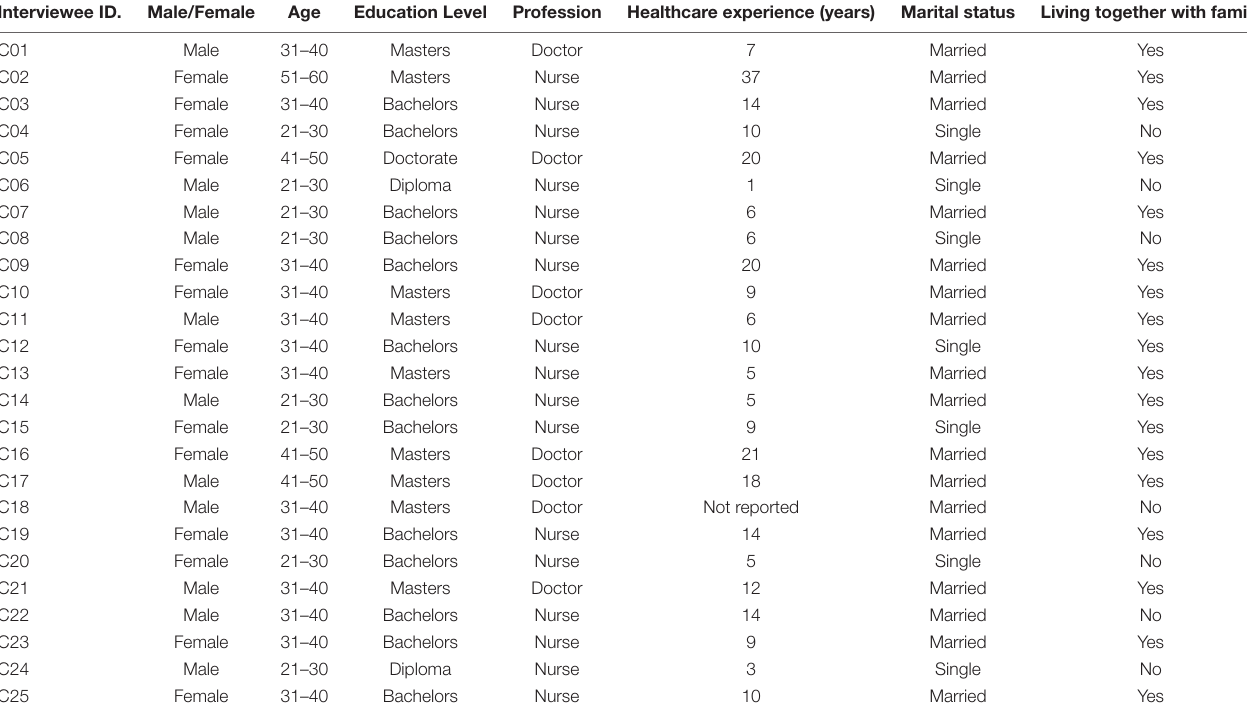
TABLE 1 | Demographic characteristics of 25 study interviewees from the medical deployment team. Interviewee